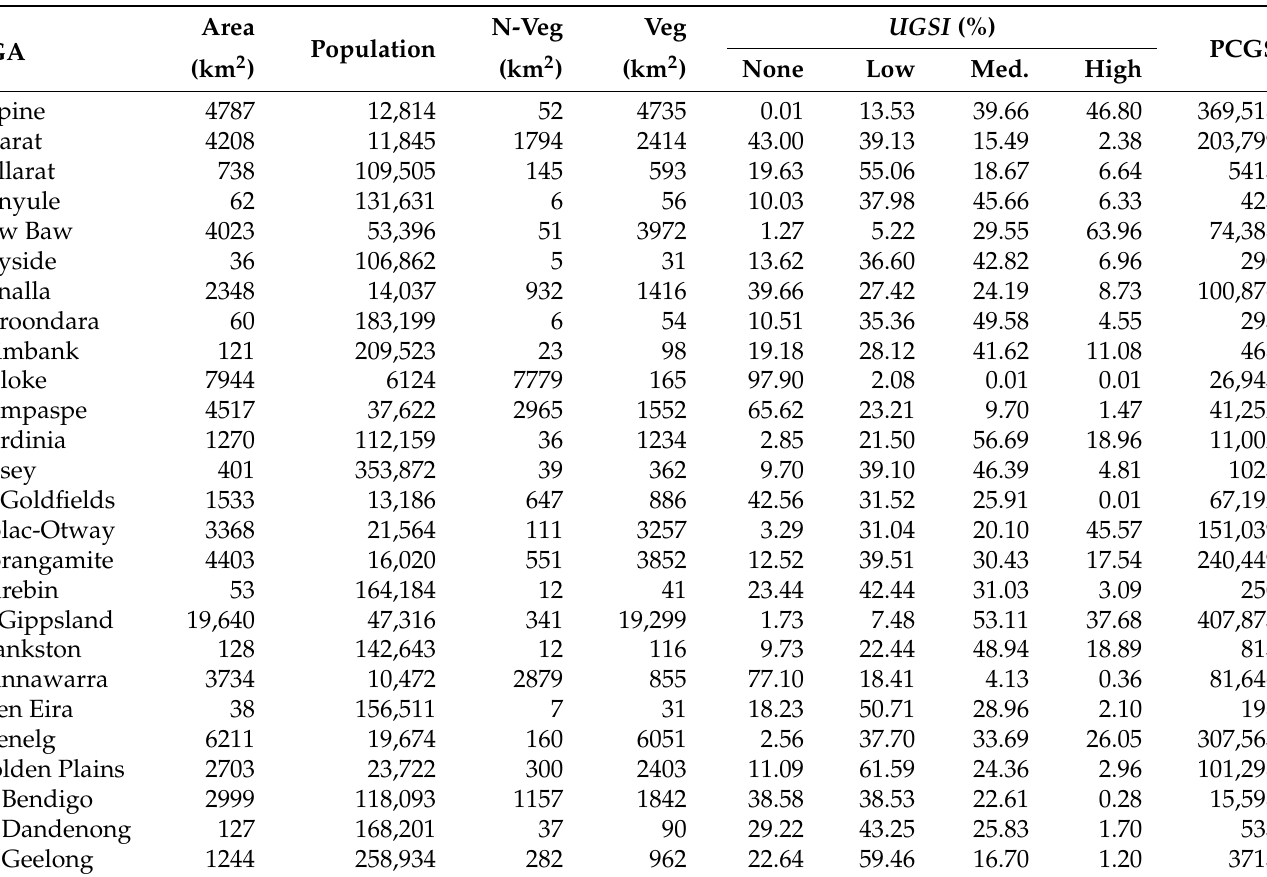
Table 11. Urban Green Space Index ( UGSI ) and Per Capita Green Space ( PCGS ) calculation of different LGAs of Victoria, Australia. Note that the unit of PCGS is m 2